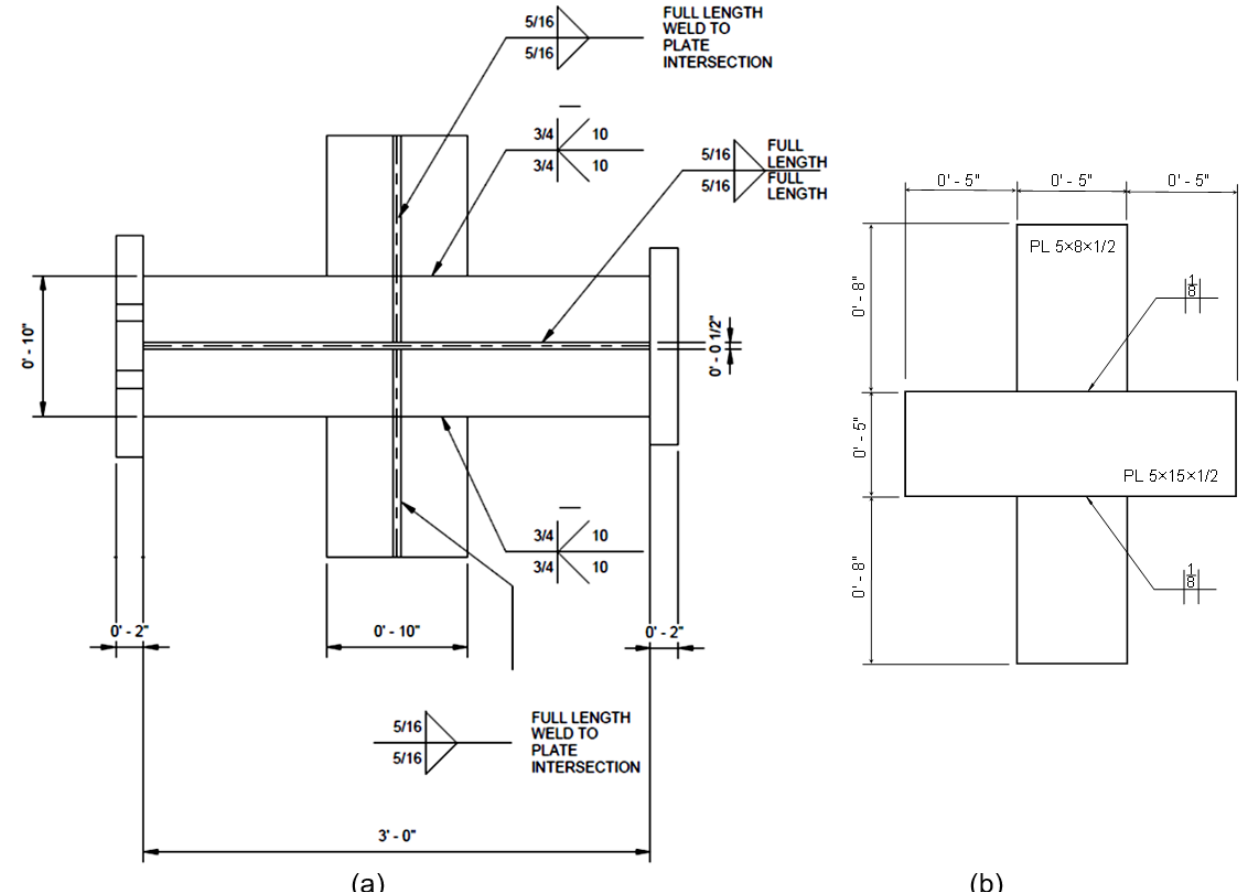
Figure 22. Gate section F13 fabrication details for ( a ) full-scale specimen (all weld and plate dimension in inches) and ( b ) half-scale specimen (all weld and plate dimensions in inches).